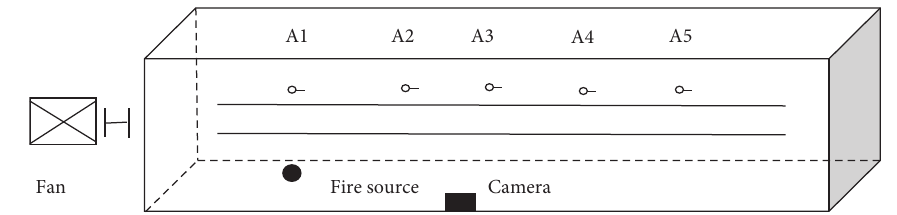
Figure 1: Tunnel platform.